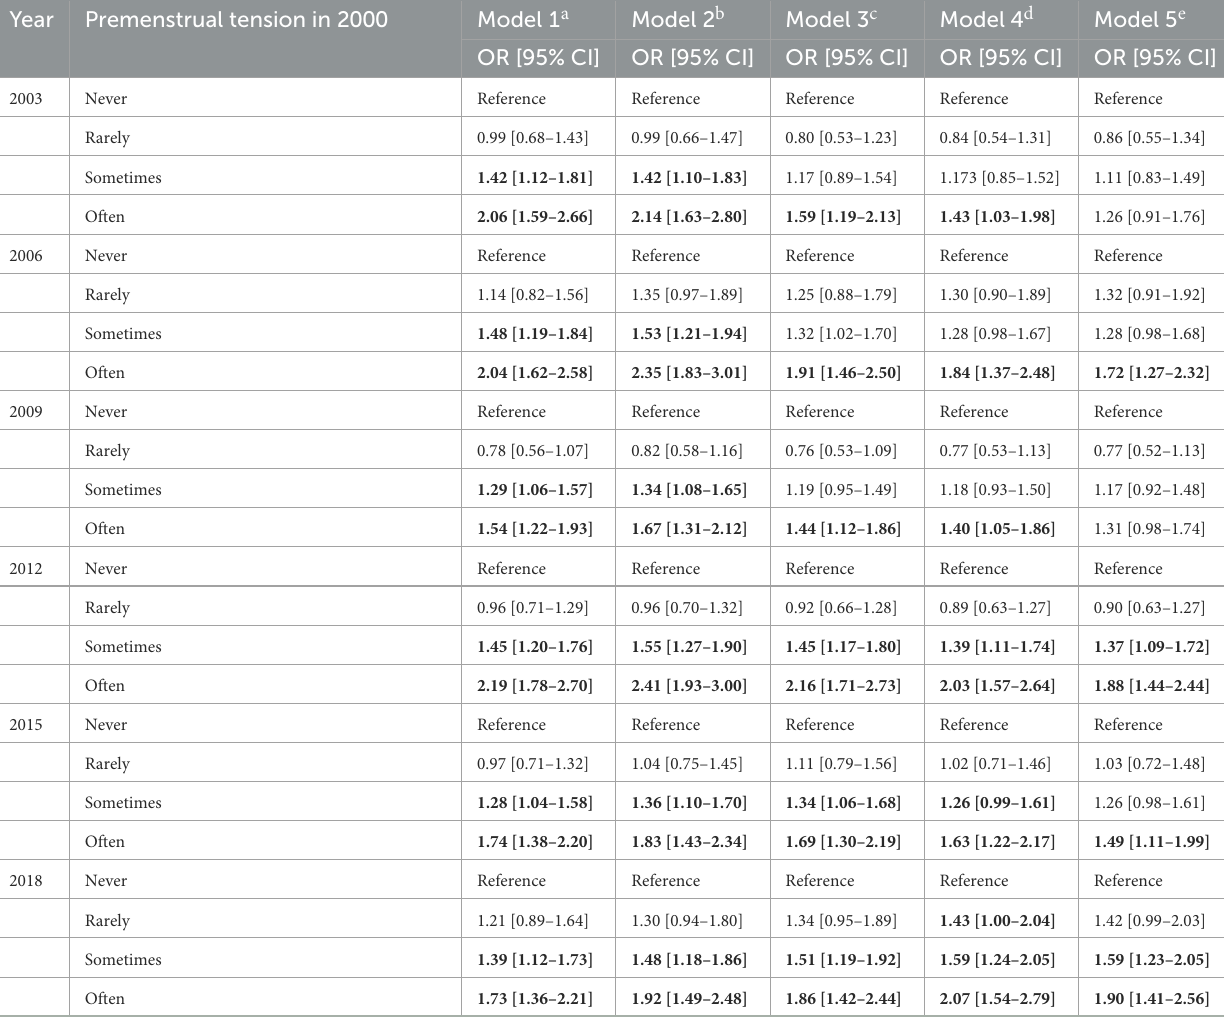
TABLE 3 Adjusted and unadjusted models for the association between self-reported frequency of PMS symptoms in 2000 and self-reported diagnosis of depression at each follow-up